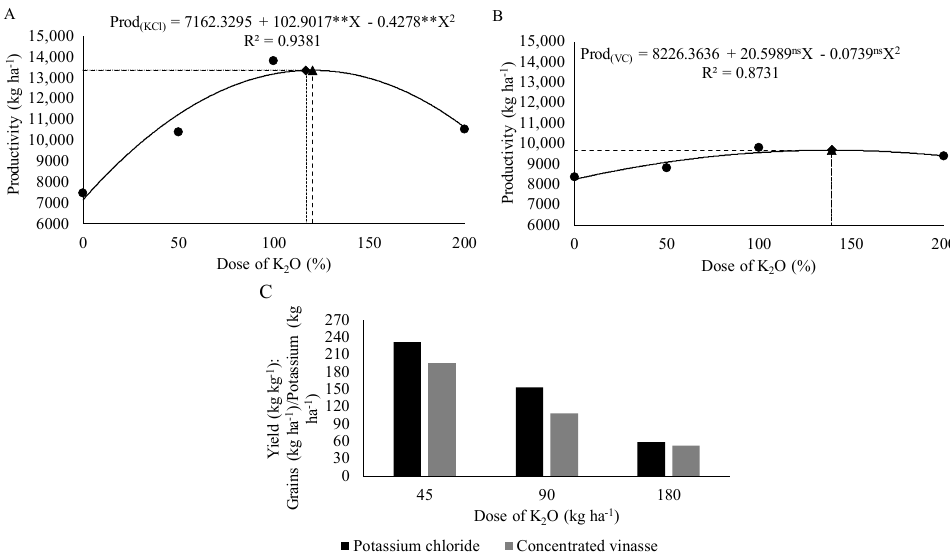
Figure 4. Maximum technical efficiency (MET) and economic efficiency (MEE) of concentrated vi- nasse (VC) and potassium chloride (KCl) at the applied potassium doses (45 kg ha − 1 = 50%, 90 kg ha − 1 = 100%, and 180 kg ha − 1 = 200%) ( A , B ) and yield obtained using these potassium sources relative to the amount of potassium applied ( C ). ** and *: significant at 1% or 5% probability. As an alternative source to organic potassic fertilizers, grain yield produced using con- centrated vinasse as a function of that produced using potassium chloride was 0.84, 0.71, and 0.89 kg at the 45 kg ha − 1 , 90 kg ha − 1 , and 180 kg ha − 1 doses, respectively (Figure 5A). Furthermore, the agronomic efficiency index (IEA) of concentrated vinasse, which rep- resents the agronomic efficiency of the fertilizer relative to the lack of fertilizer (herein, 0% dose) or a standard fertilizer (herein, potassium chloride), was the highest at the 90 kg ha − 1 dose (68.5%), followed by the 45 kg ha − 1 (65.07%) and 180 kg ha − 1 (44.92%) doses (Figure 5B).